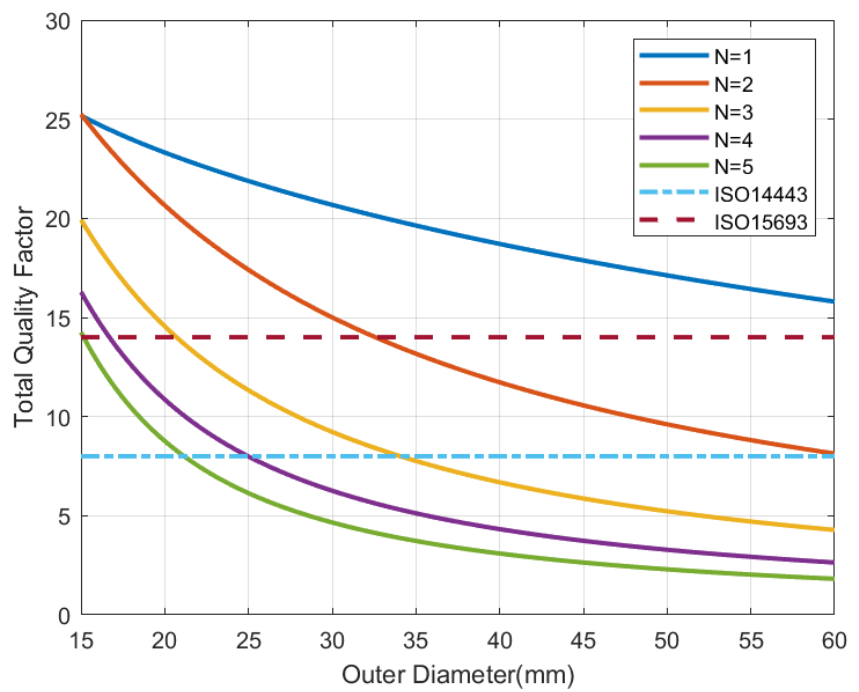
Figure 8. Simulated total tag quality factor as a function of the outer diameter for a square antenna with a different number of